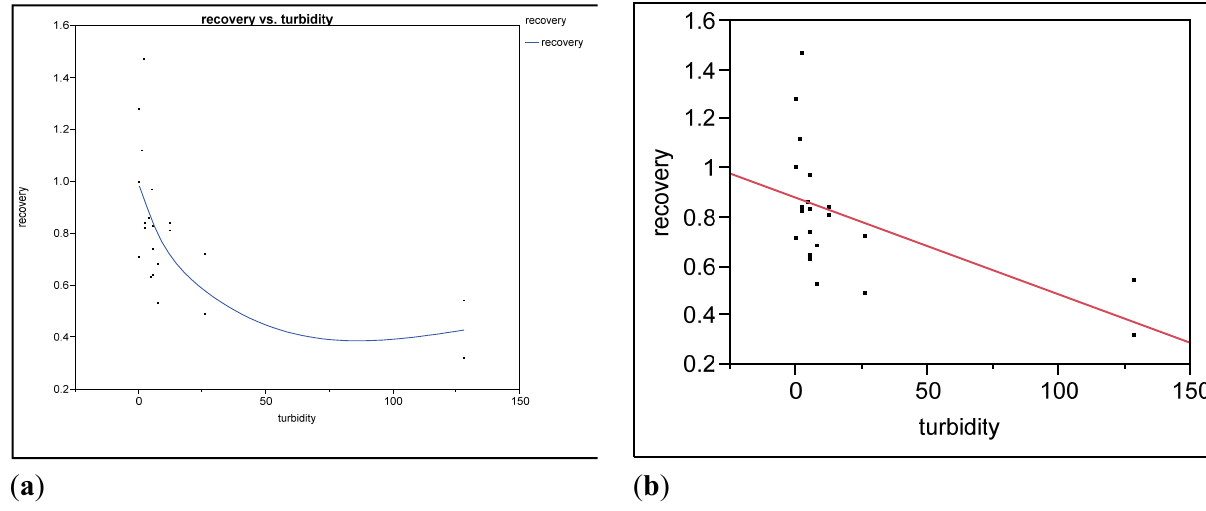
Figure 2. UF recovery efficiency by turbidity, for Φ X174, with spline ( a ); and linear regression line overlaid ( b